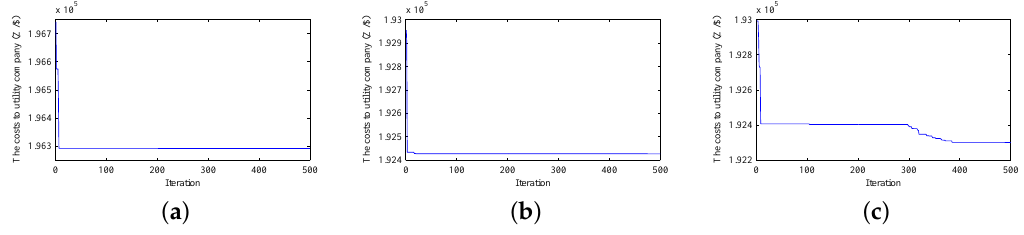
Figure 5. The convergence curve of the fitness value with different number of relays. ( a ) The convergence of the fitness value with one relay; ( b ) The convergence of the fitness value with six relays; ( c ) The convergence of the fitness value with ten